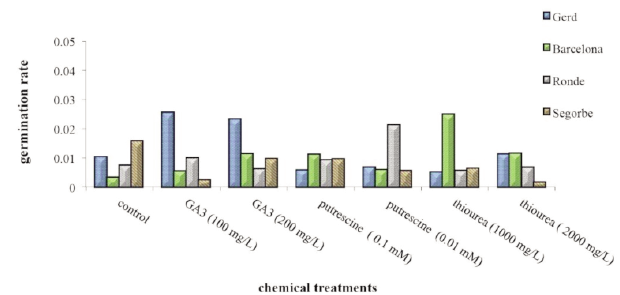
fig. 2 - effect of chemical treatments and cultivars on seed ger- mination rate of hazelnut cultivars.